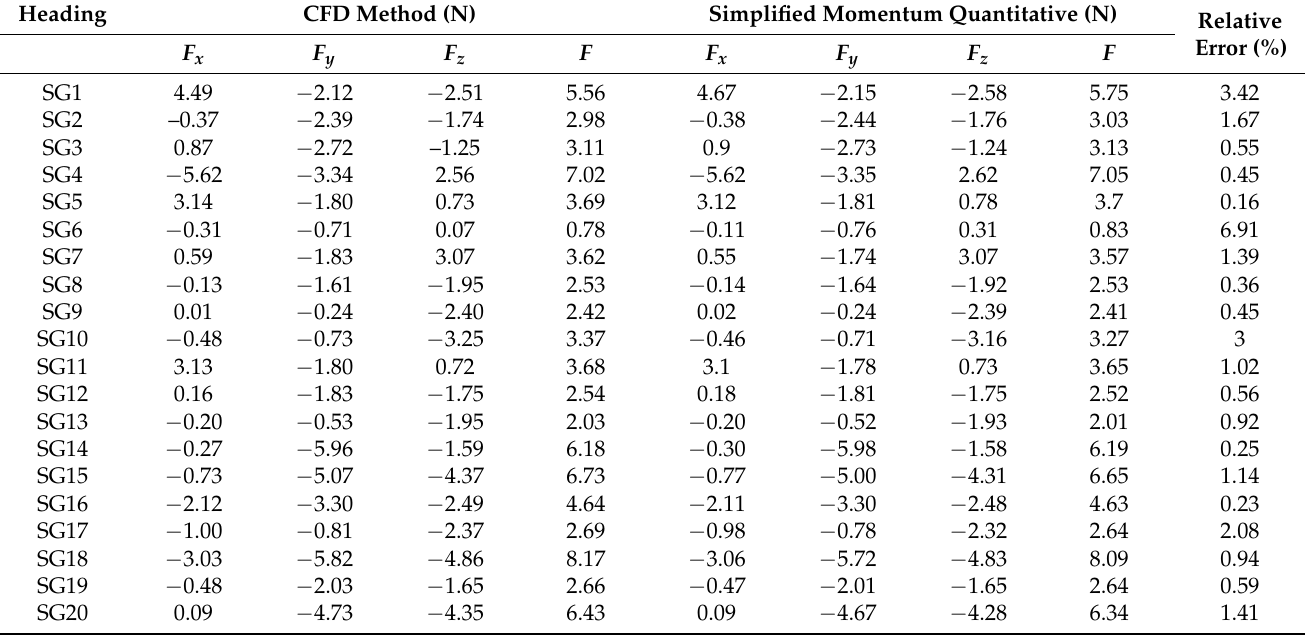
Table 1. The displacement force as calculated by the CFD method and simplified momentum quantitative